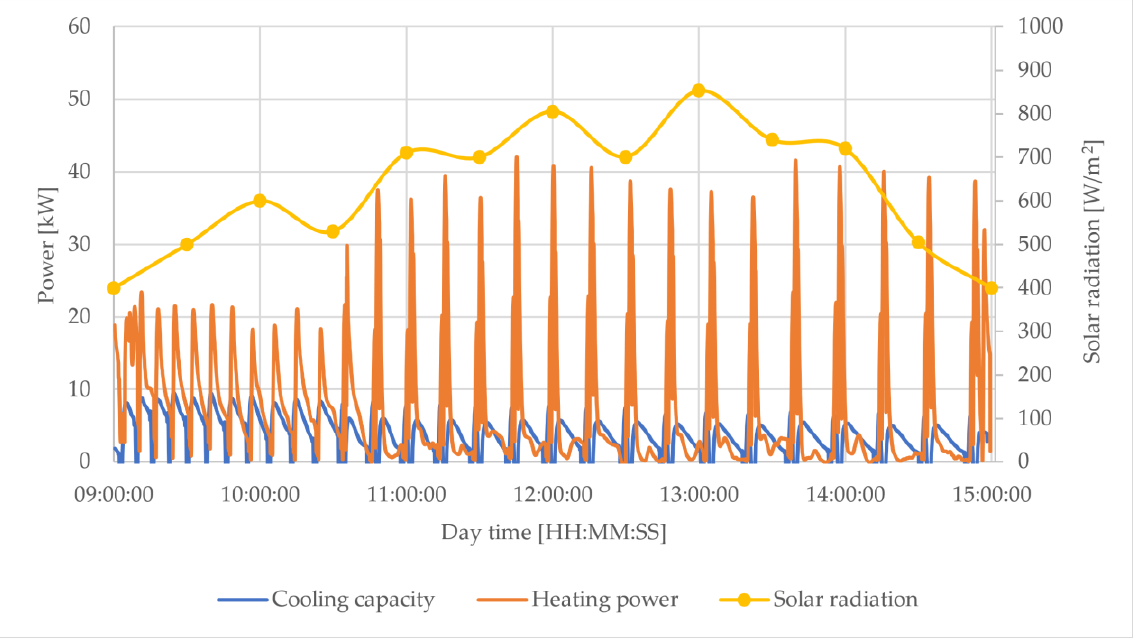
Figure 13. Fluctuation of heating and cooling power values over time for 31st July.